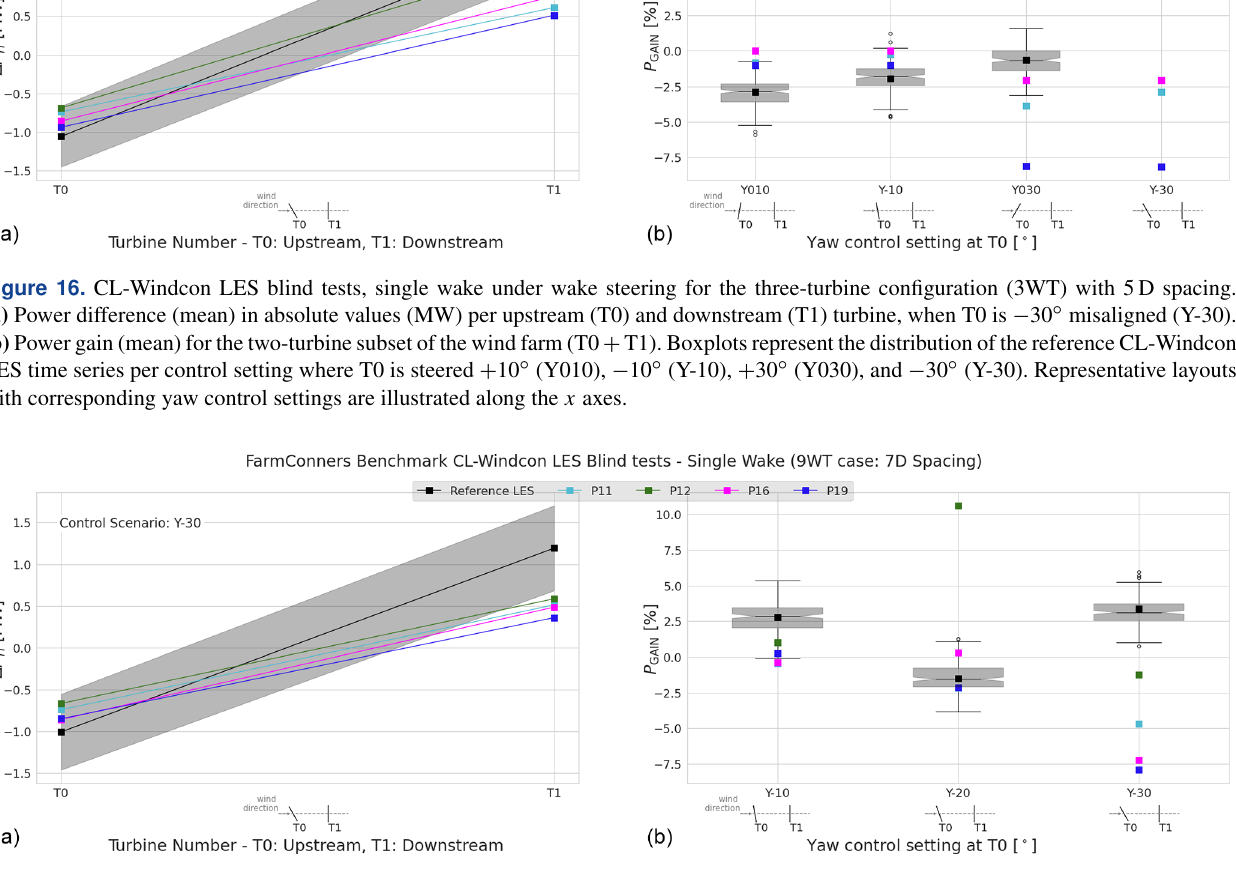
Figure 17. CL-Windcon LES blind tests, single wake under wake steering for the nine-turbine configuration (9WT) with 7D spacing. (a) Power difference (mean) in absolute values (MW) per upstream (T0) and downstream (T1) turbine, when T0 is − 30 ◦ misaligned (Y-30). (b) Power gain (mean) for the two-turbine subset of the wind farm (T0 + T1). Boxplots represent the distribution of the reference CL- Windcon LES time series per control settings where T0 is misaligned − 10 ◦ (Y-10), − 20 ◦ (Y-20), and − 30 ◦ (Y-30). Representative layouts with corresponding yaw control settings are illustrated along the x